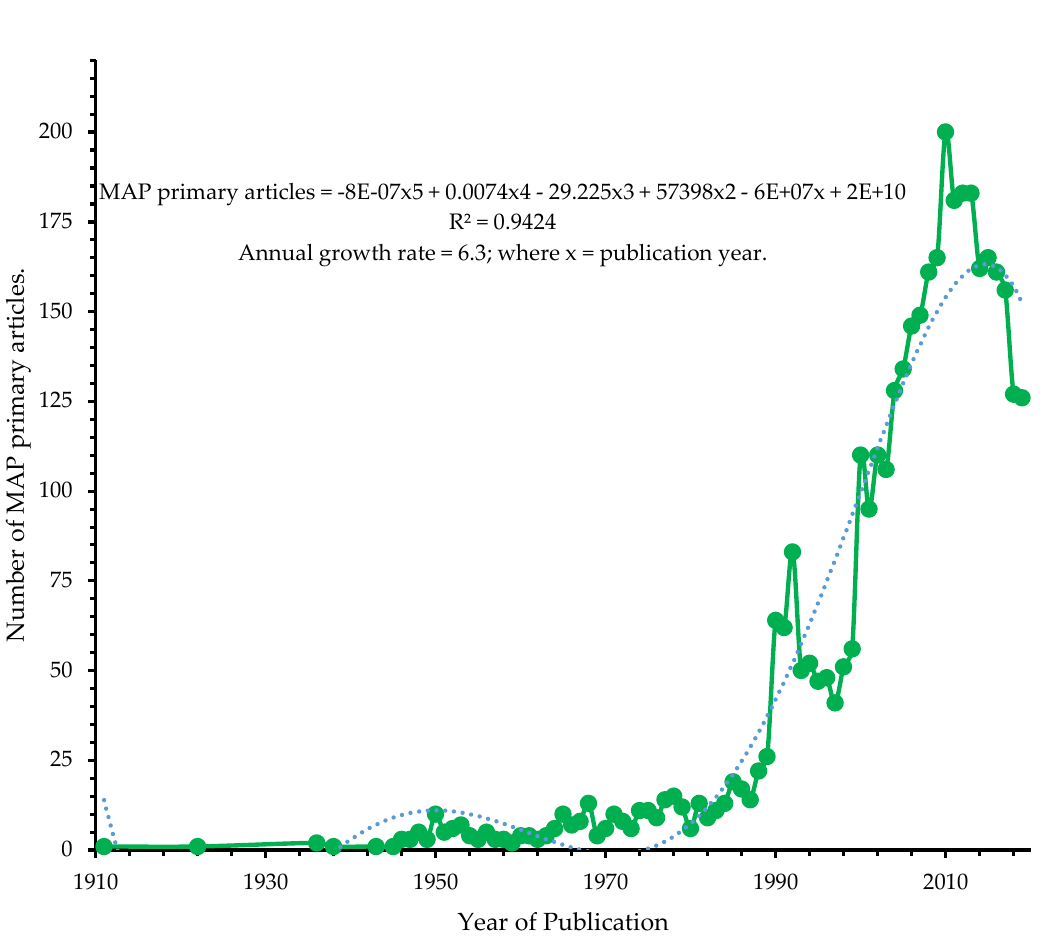
Figure 3. Annual scientific output related to M. avium subsp. Para tuberculosis research from 1911– 2019.